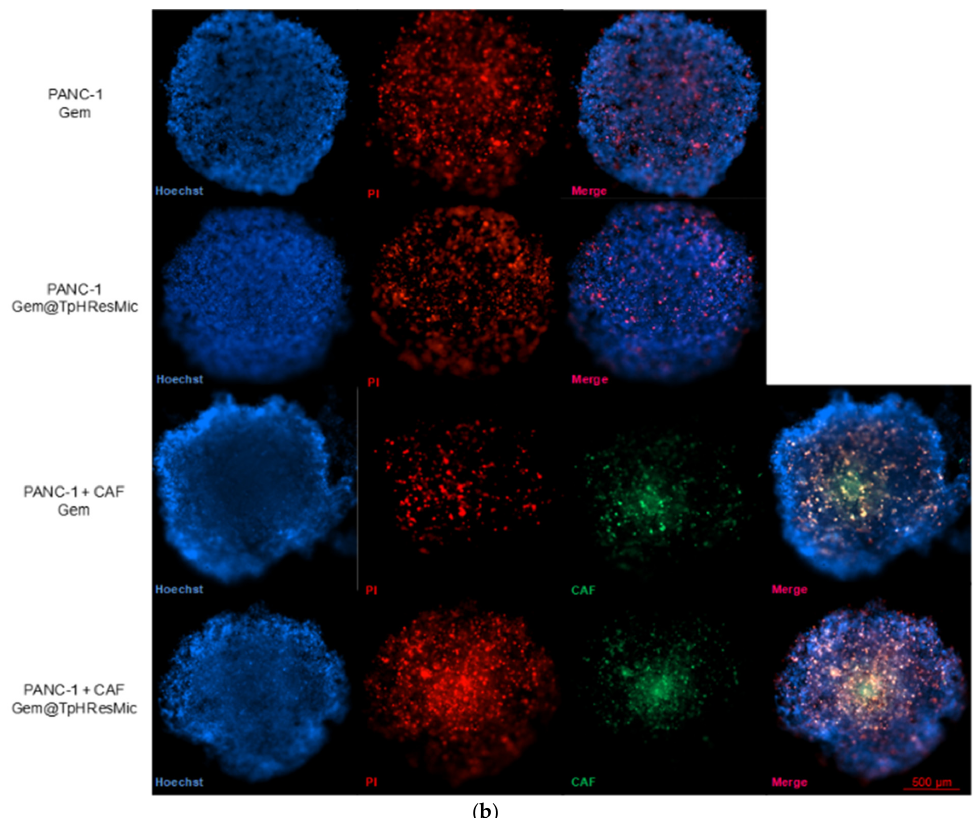
Figure 11. ( a ) Representative FCM dot plots of viability analysis conduct on PANC − 1 and PANC − 1/CAF spheroids after treatment with Gem@TpHResMic or free Gem. The histograms plots show the % of dead cells in all conditions, reported as the mean ± SD of three independent experiments. ( b ) Representative fl uorescence images of viability evaluation in PANC − 1 or PANC − 1/CAF spheroids (blue—nuclei; green—CAF; red—dead cells). *** p < 0.001 . Scale bar 500 µm.